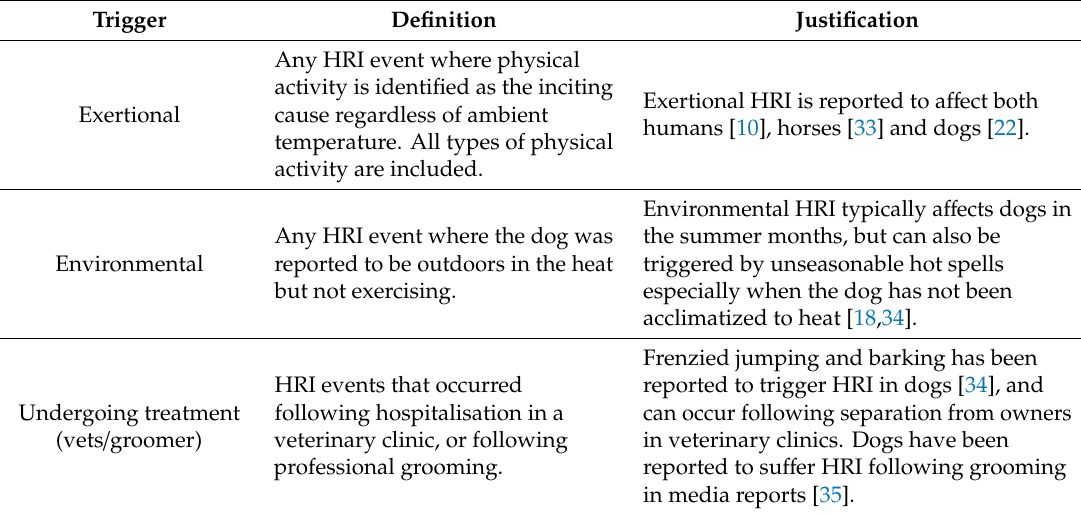
Table 1. Definitions of heat-related illness (HRI) triggers in UK